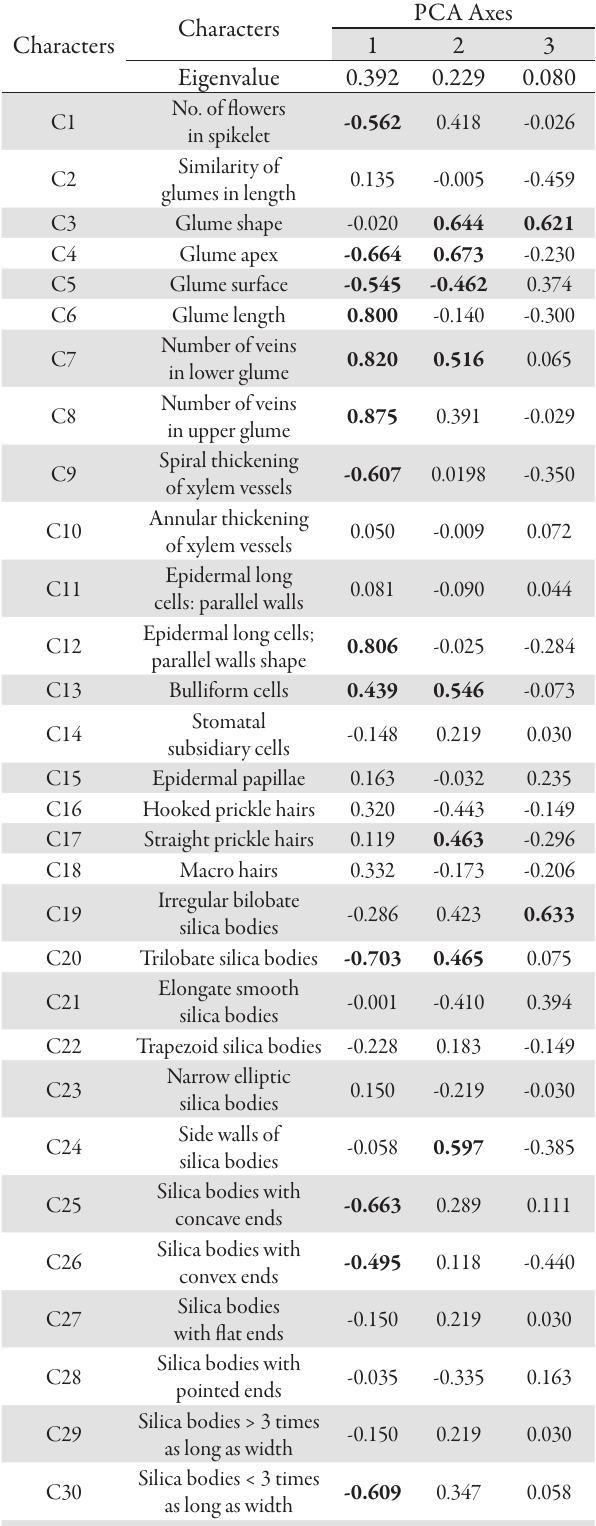
Tab. 5. Factor loadings of the 31 characters (C1-C31) on the first three principal components axes. Highest loadings in bold